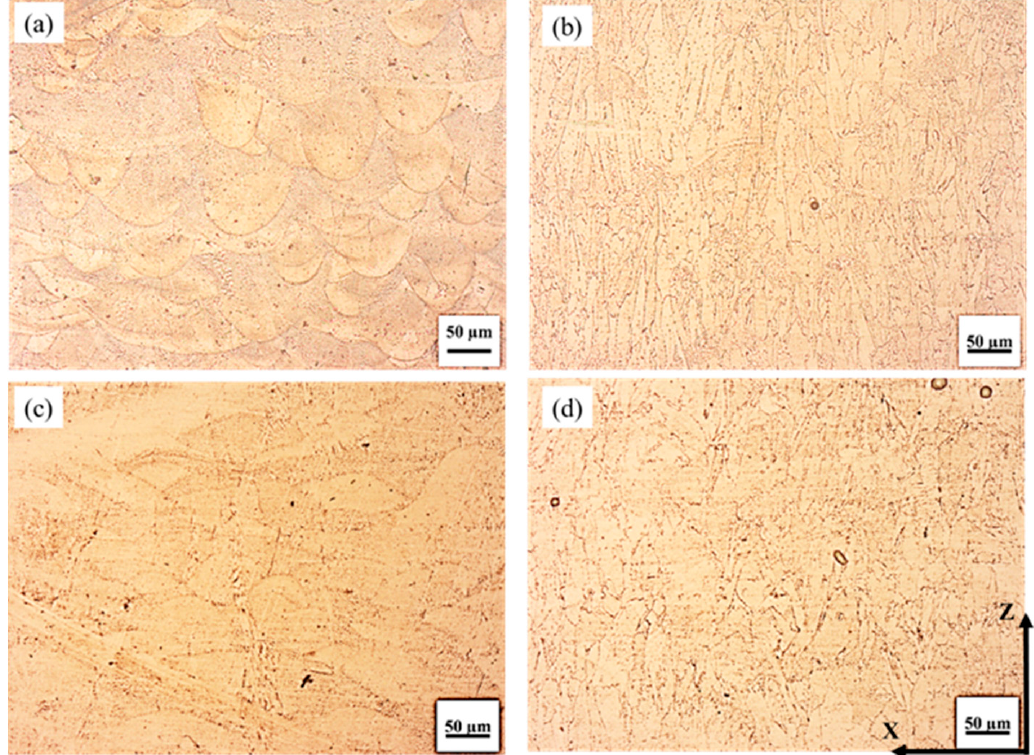
Figure 3. Optical microstructure on XZ plane in ( a ) AB, ( b ) HT, ( c ) SP, and ( d ) HTSP.